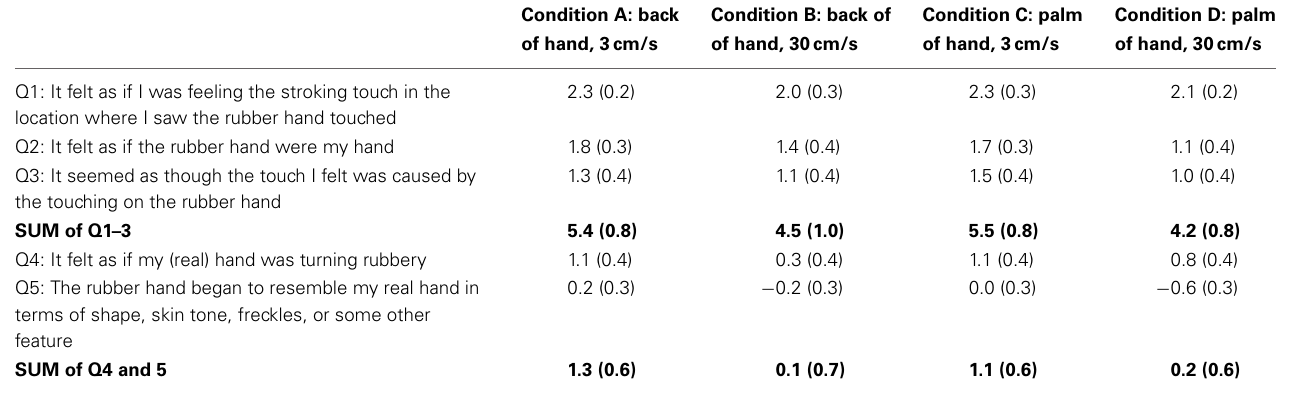
Table 1 | Mean scores ( ± 1 s.e.m) for all questionnaire items across all four